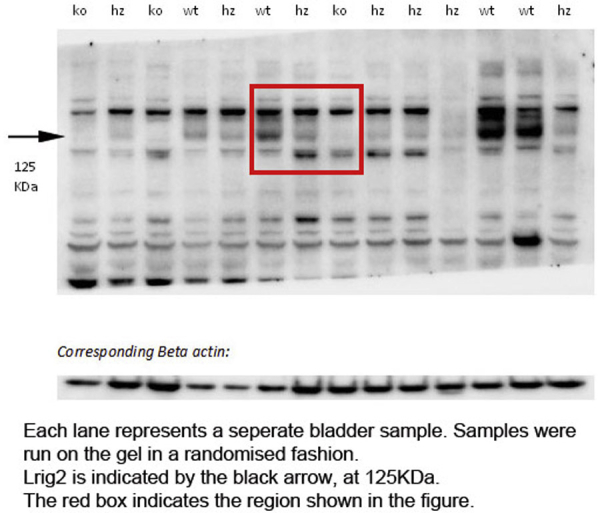
Western blot quantification of Lrig2 protein levels in bladder lysates. Total protein was extracted from wild-type, Lrig2 heterozygous, and Lrig2 homozygous mutant mouse bladders and 35 μg resolved on a polyacrylamide gel. Each lane represents a separate bladder sample, with genotypes loaded at random. Wild-type Lrig2 is indicated by the black arrow, at 125 KDa. The red box indicates an example of wild-type, heterozygous, and homozygous bladder samples, with strong, low, and absent Lrig2 bands, respectively.